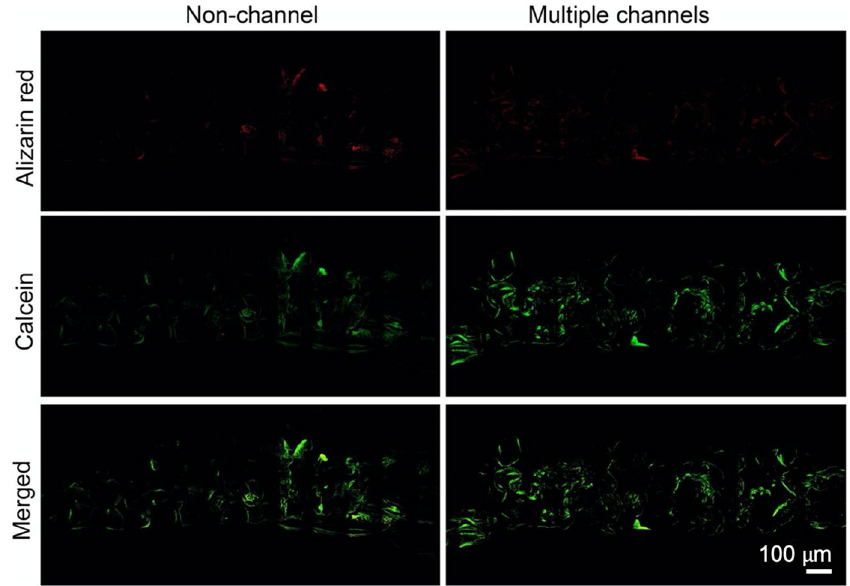
Figure 9. Flurochrome labeling: fluorescent labeling of new bone formation over time. Images in red and green present the calcified tissue,